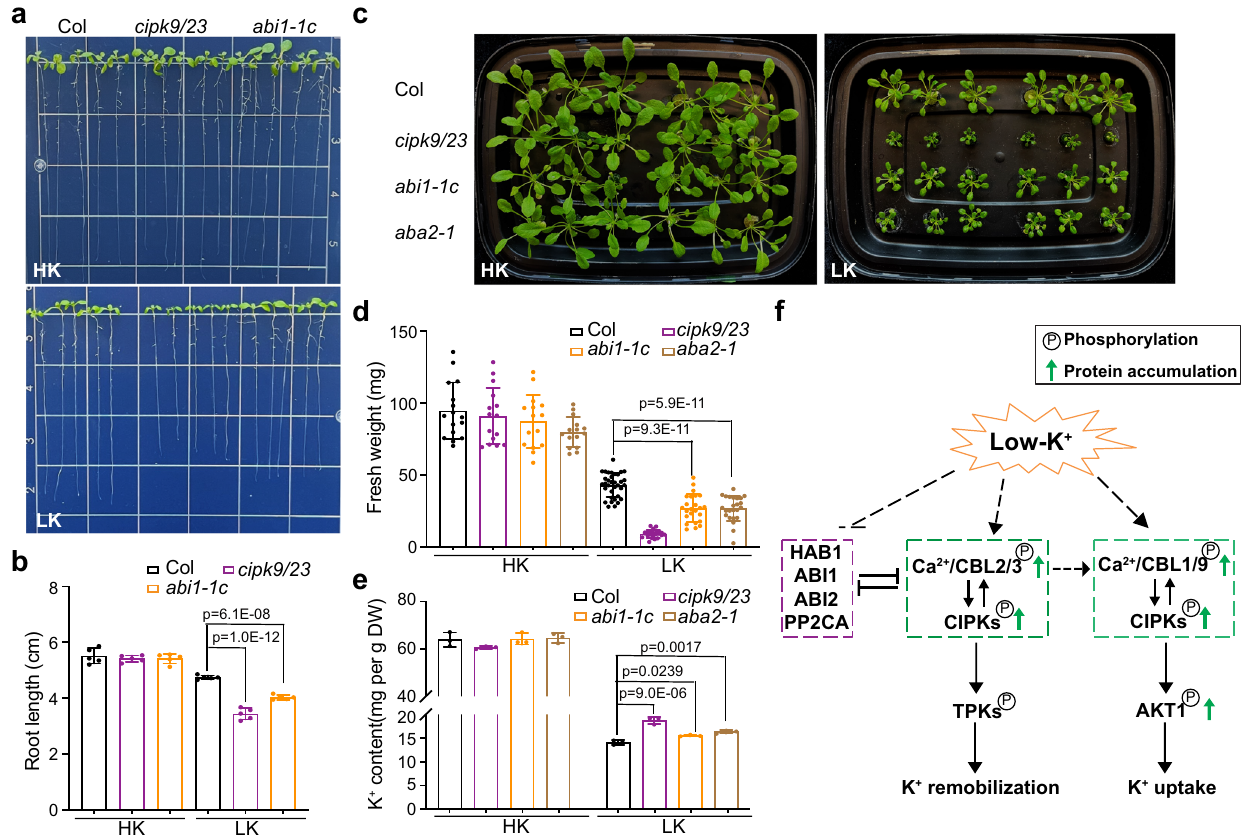
Fig. 6 | abi1-1c and aba2-1 mutant plants are hypersensitive to external K + de fi ciency. a Representative images of wild type (Col-0), cipk9/23 double mutant, abi1-1c mutants under high- or low-K + in post-germination assays. The seedlings were grown under suf fi cient-K + (20mM) conditions for 4 days, followed by a transfer to high-K + (20mM) or low-K + (5 μ M) condition and grown for